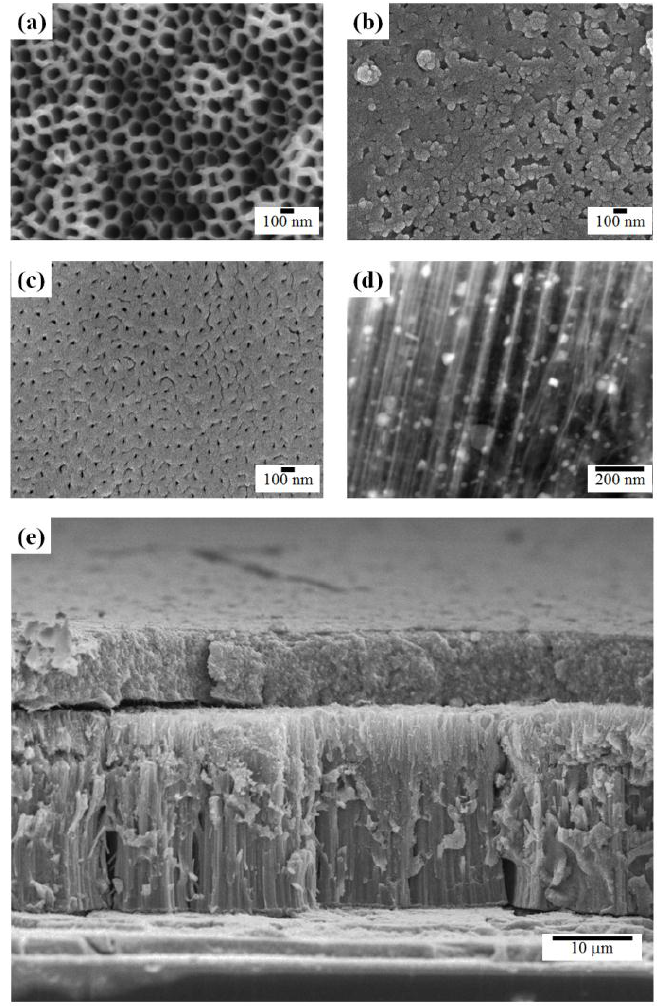
Figure 2. Field emission scanning electron microscope (FE-SEM) images of the ( a ) top, ( b ) bottom, and ( c ) bottom of post–ion milling freestanding TiO 2 nanotube arrays; ( d ) a high-angle annular dark-field (HAADF) image of Ag NPs in the channel of TiO 2 nanotube arrays; and ( e ) a side view of the active layer with freestanding TiO 2 nanotube arrays and a scattering layer.